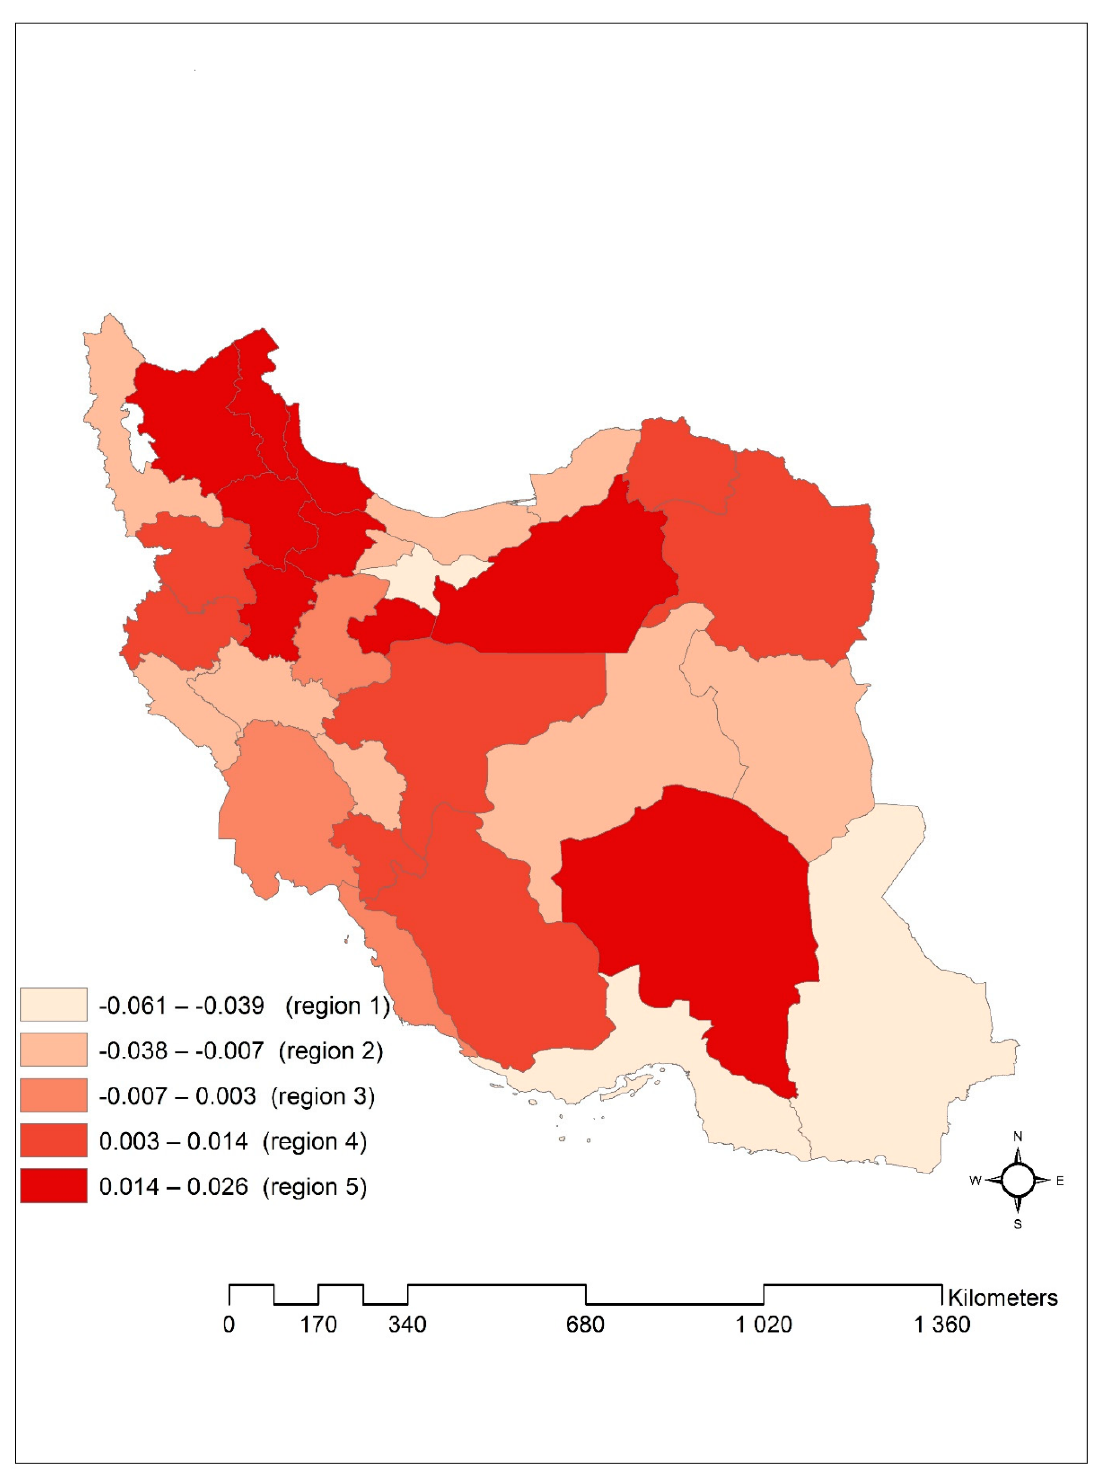
Figure 2. Posterior median of spatial frailties from the log-logistic model with convolution prior, Iran provinces. Figure 3 maps the posterior median of spatially correlated plus uncorrelated random effects from the best-selected model. As can be seen, there is a relatively notable geographical variation in duration to cure of these patients in Iran.